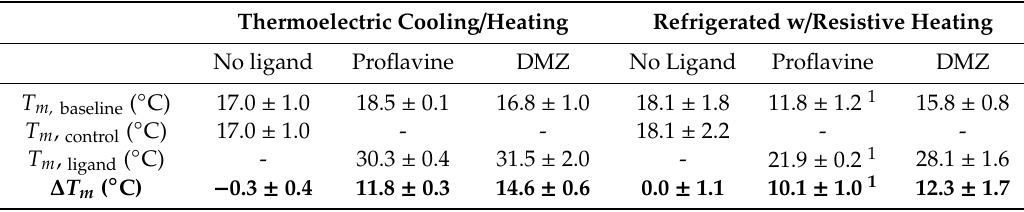
Table 1. Summary of duplex thermal